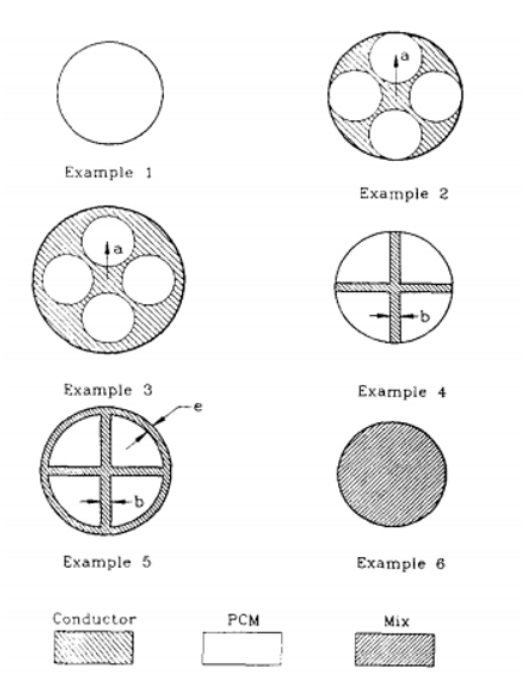
Figure 8 Thermal energy storage